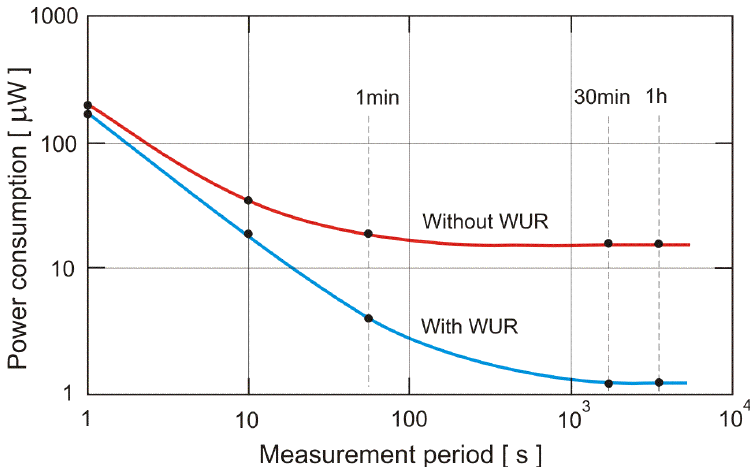
Figure 8. Power consumption with and without